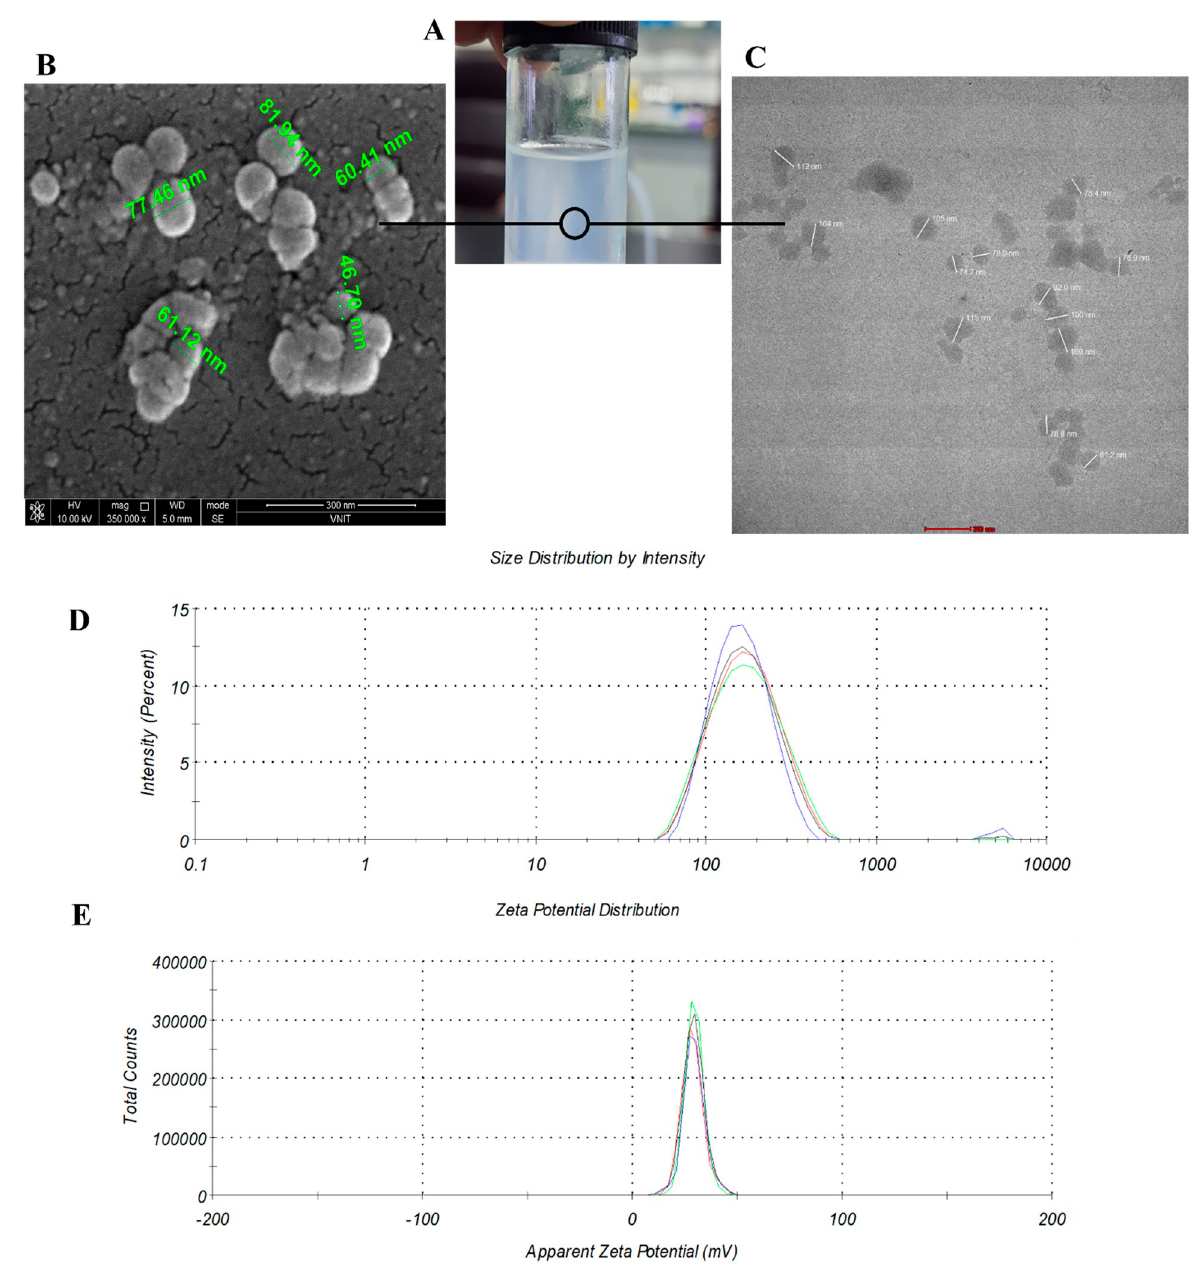
Figure 1. Physical characterization of lipid nanoparticles. ( A ) Appearance of lipid nanoparticles (LNPs) solution, ( B ) SEM analysis of LNPs ( C ) TEM analysis of LNPs ( D ) Size distribution by DLS and, ( E ) Zeta potential.